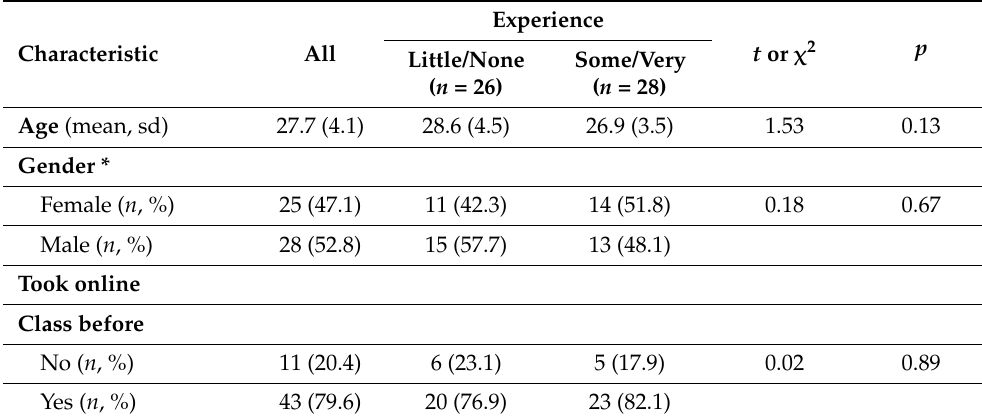
Table 1. Comparisons of demographic characteristics between those who were less vs. more experi- enced with videoconferencing before March 2020 (N = 54).